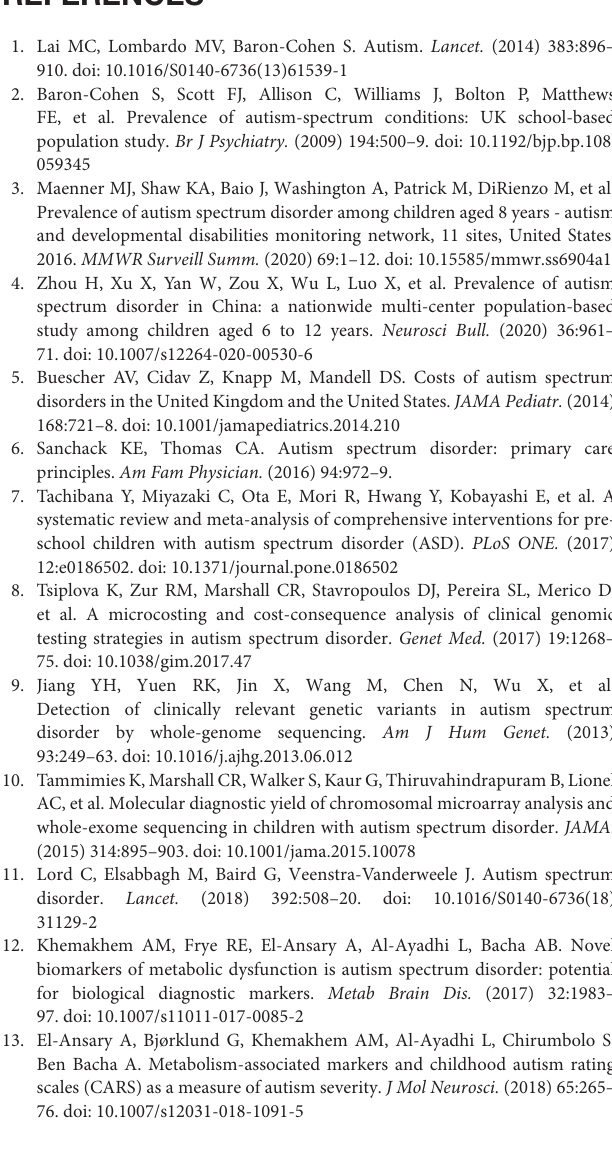
Supplementary Table 2 | Sex stratification analysis of the AUC of differential metabolites. Supplementary Table 3 | Age stratification analysis of the AUC of differential